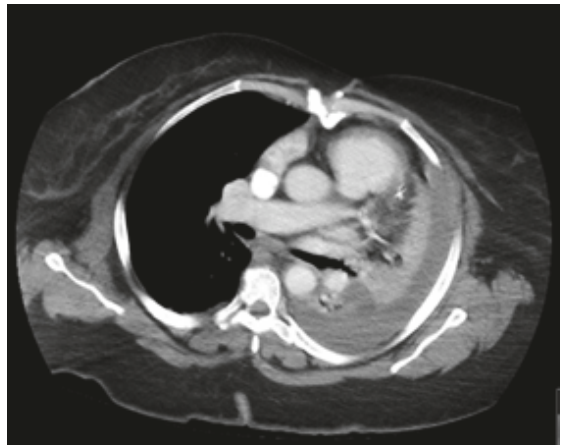
Figure 3: Chest CT with IV contrast after drainage of one